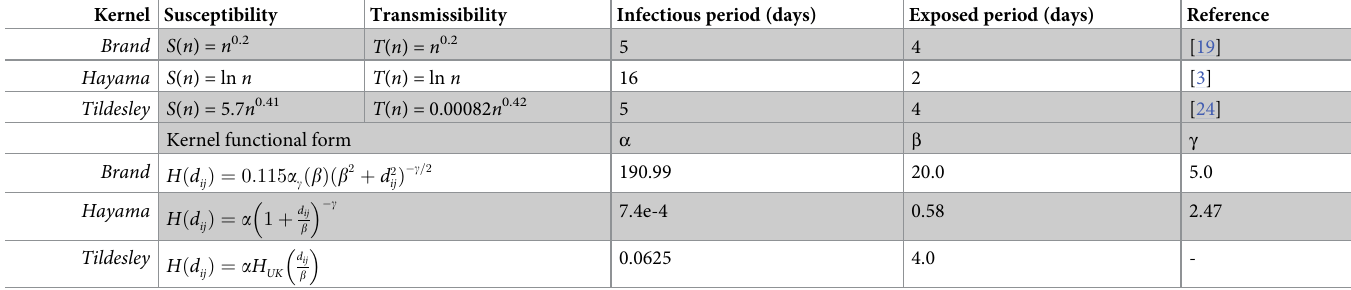
Table 3. Kernel parameters and functional forms. Infectious period refers to the number of days that an infected premises is infectious (i.e. can transmit the pathogen to another premises), and exposed period refers to the number of days between date of transmission and becoming infectious. For the Tildesley kernel, H UK represents the nonparametric kernel fitted to the U.K. 2001 FMD outbreak